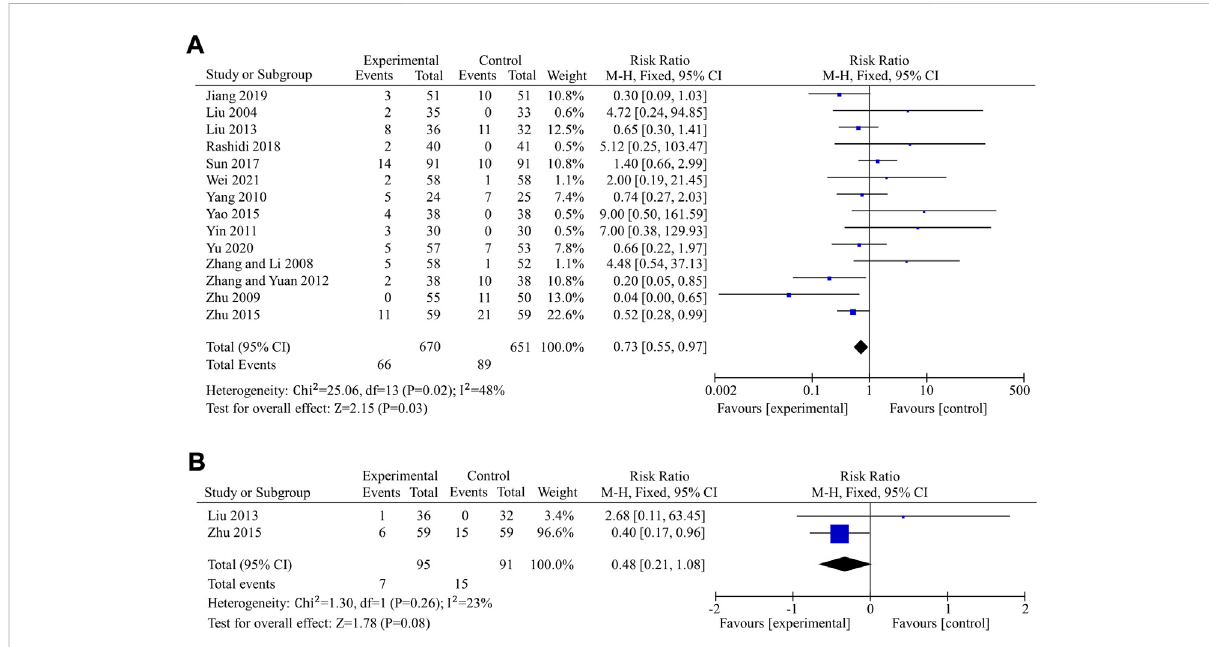
FIGURE 8 Meta-analysis of the effect of BBR on hypoglycemic events. (A) Total adverse events (B)